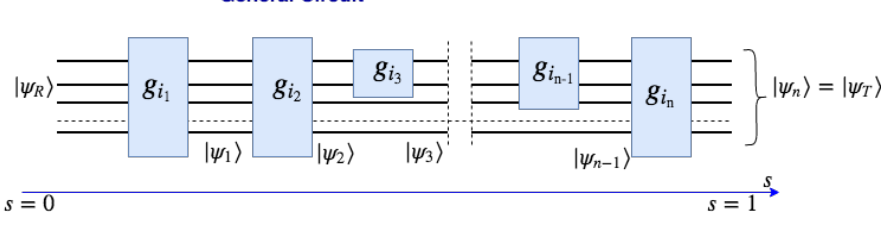
i is prepared beginning with j T